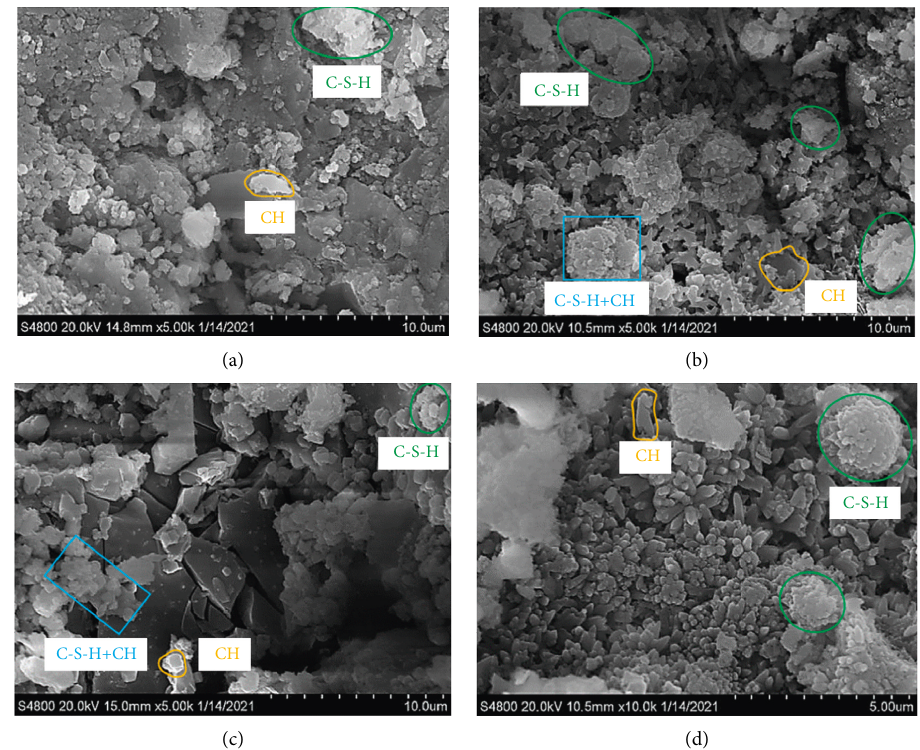
Figure 15: Micromorphology of cement concrete at different ages of S-100-0.200%: (a) 3d (b) 14d, (c) 28d, and (d)